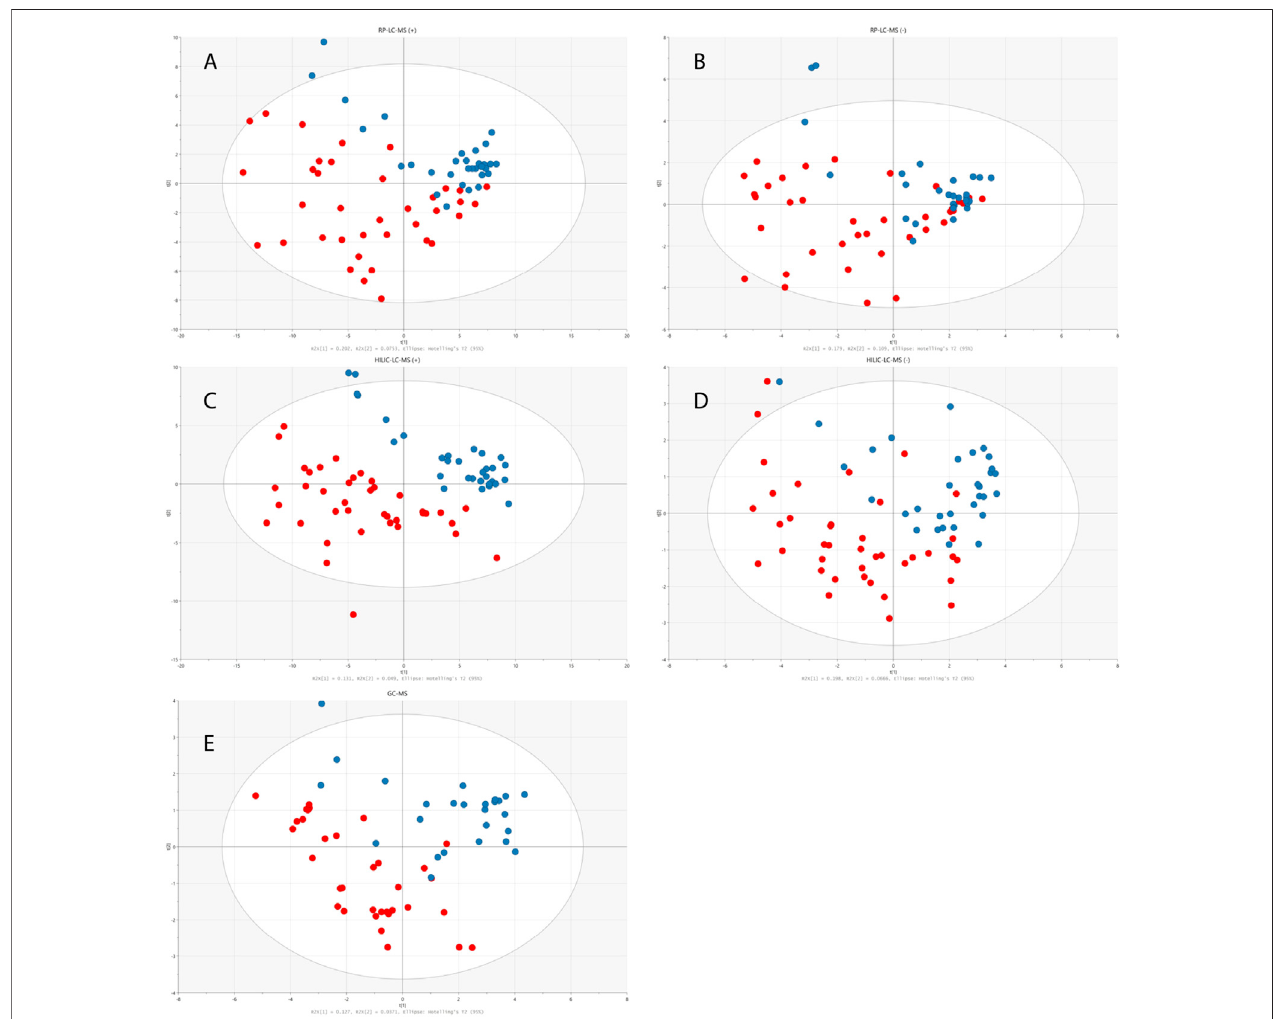
FIGURE 3 | PLS-DA models built on data obtained from RP-LC-TOF-MS analysis in positive (A) ( R 2 (cid:2) 0.25, Q 2 (cid:2) 0.282, CV-ANOVA p < 0.001) and negative (B) ( R 2 (cid:2) 0.453, Q 2 (cid:2) 0.236, CV-ANOVA p (cid:2) 0.013) ionization modes, HILIC-LC-TOF-MS analysis in positive (C) ( R 2 (cid:2) 0.227, Q 2 (cid:2) 0.505, CV-ANOVA p < 0.001) and negative (D) ( R 2 (cid:2) 0.264,Q 2 (cid:2) 0.271,CV-ANOVA p < 0.001)ionizationmodesandfromGC-MSanalysis (E) ( R 2 (cid:2) 0.164,Q 2 (cid:2) 0.174,CV-ANOVA p (cid:2) 0.017).Redcircles correspond to samples from disease group, while blue ones represent healthy